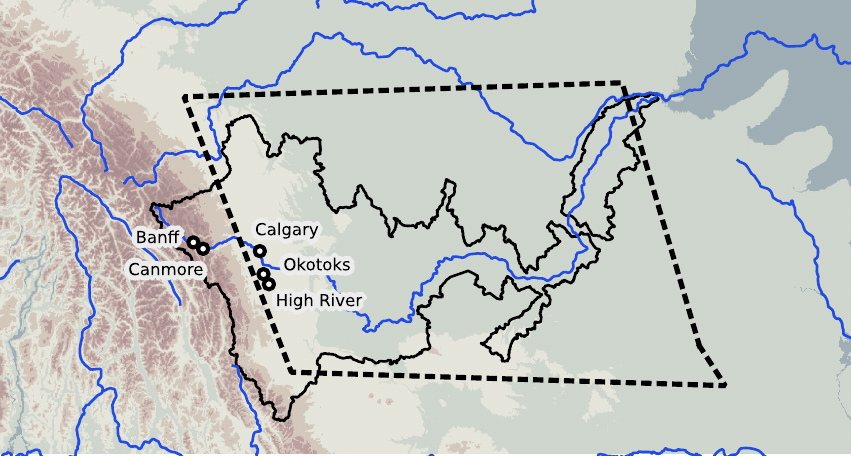
Figure 2. Region affected by the 2013 Alberta flood, Canada. South Saskatchewan river basin (solid line), polygon from the GAALFE dataset (dashed